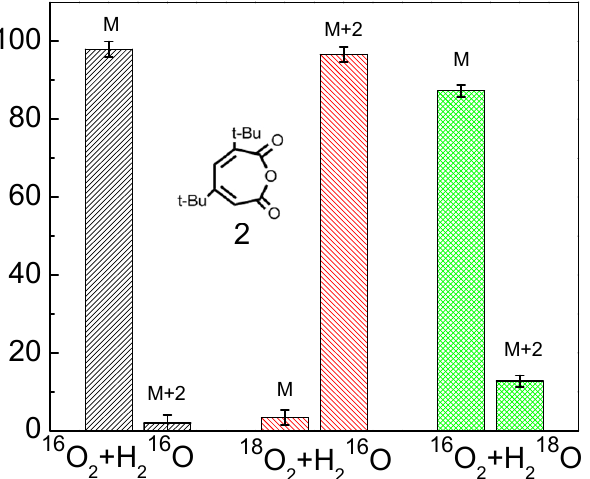
Figure 1. The oxygen-isotope distribution of product 2 under the various isotope conditions. In each panel, the horizontal axis represents the three isotope conditions: (1) Natural 16 O 2 and H 216 O; (2) 18 O 2 and H 216 O; (3) 16 O 2 and H 218 O; the vertical axis represents the oxygen-isotope distribution ratio (%); M, M+2, M+4 denote products including 0, 1, 2 atoms of 18 O in place of 16 O